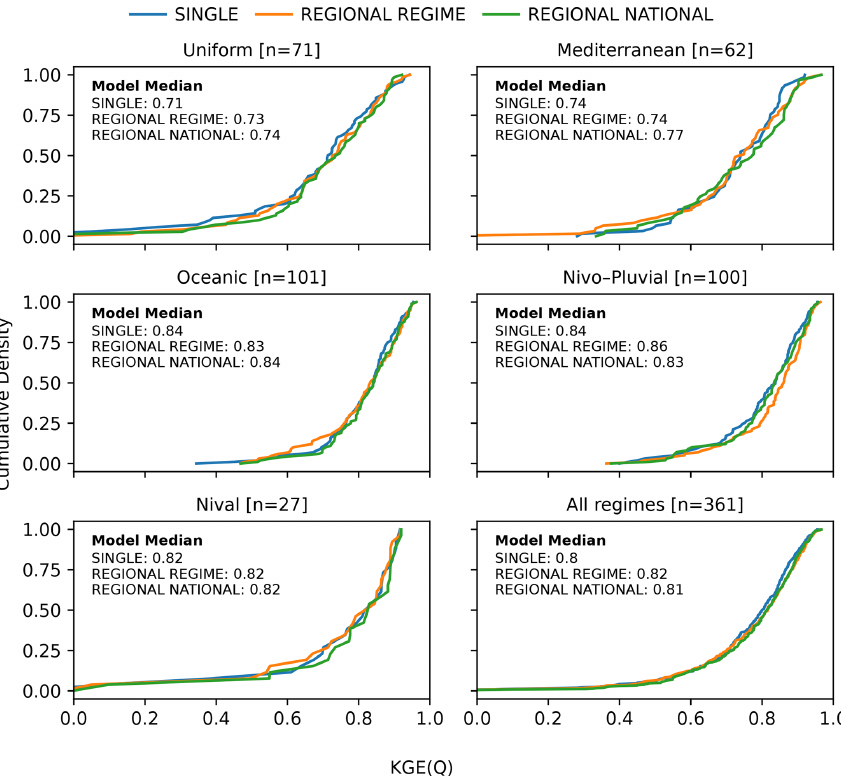
Figure 10. Cumulative distribution functions (CDFs) of the KGE scores of the test data for three LSTM models: SINGLE (blue), REGIONAL REGIME (orange), and REGIONAL NATIONAL (green). From top to bottom, the first five panels indicate the CDFs of one of the five regimes: Uniform, Mediterranean, Oceanic, Nivo–Pluvial, and Nival. The last panel corresponds to the distributions of the entire